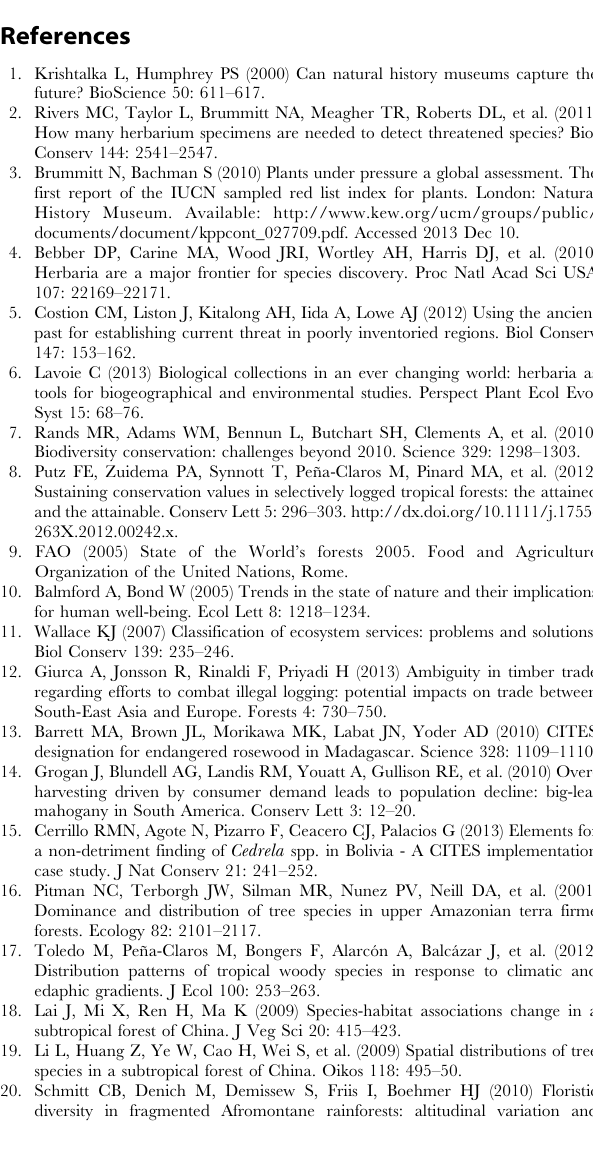
Table S1 Georeferenced vouchers or bibliographic records for selected timber species in Angola. Data from the LISC Herbarium is available through GBIF at http://www.